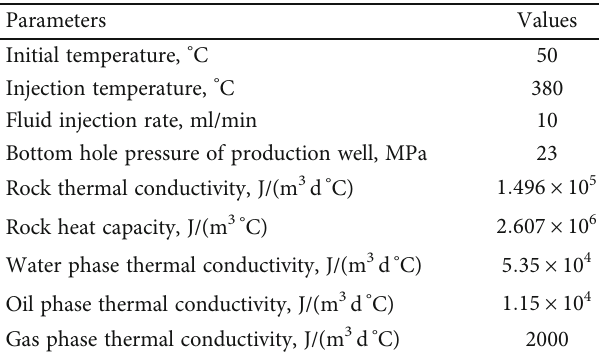
Figure 7: Oil-water and gas-liquid relative permeability: (a) oil- water relative permeability and (b) gas-liquid relative permeability. Table 1: The key properties of the